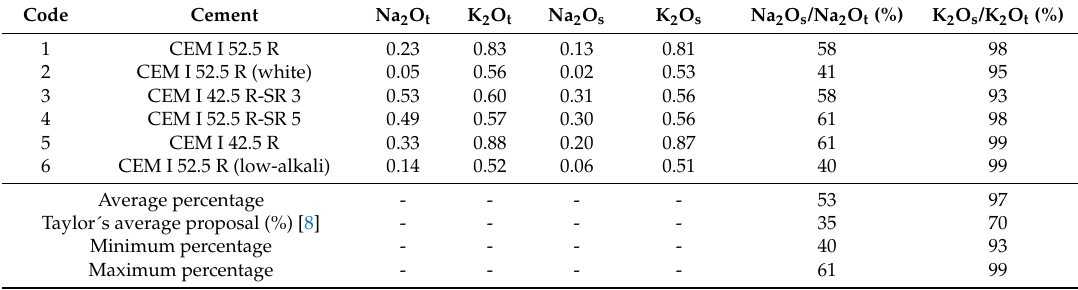
Table 4. Fractional distributions of the water-soluble alkalis (sulfate alkalis) in the total alkali content.